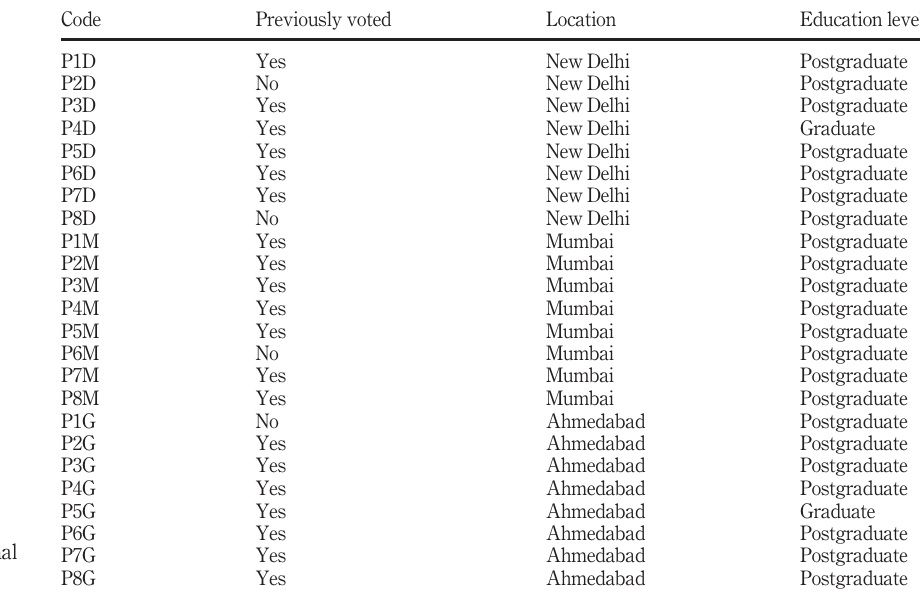
Table II. Details of external